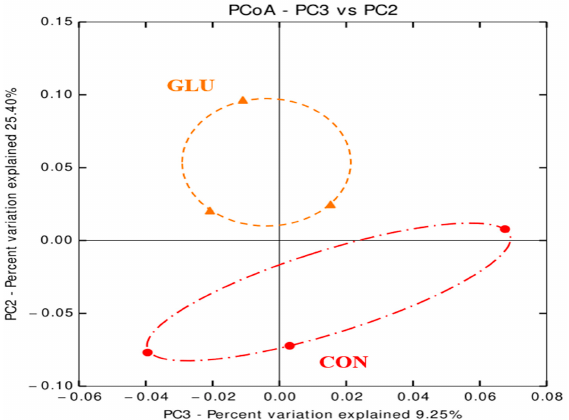
Figure 2. Discriminant analysis of the principal components of fecal microbiota ( n = 3). The six differently abundant bacteria genera represent the number of variables in the model. Individual pig samples for treatments are designated with the following symbols: CON = a typical weaner diet (red, ● ), GLU = CON with 0.5% glutamic acid (orange, ▲ ). R-value = 0.678, p -value < 0.05.